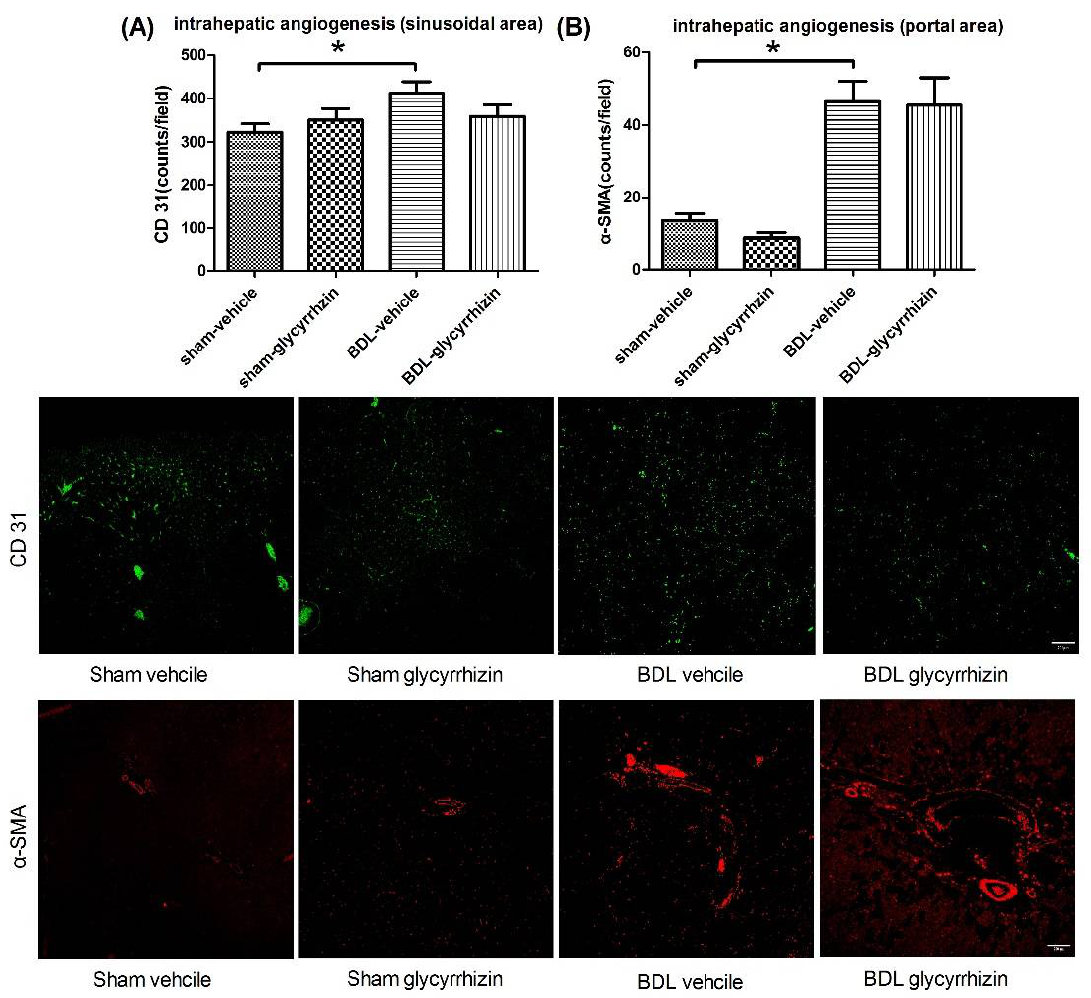
Figure 7. Effects of glycyrrhizin on intrahepatic angiogenesis. ( A ) Intrahepatic angiogenesis over sinusoidal area was evaluated by CD31 staining targeting endothelial cells. ( B ) Intrahepatic angiogenesis over portal area was investigated by α -SMA staining for vascular smooth muscle cells. The results were consistent. Intrahepatic vessels increased significantly in BDL-vehicle group compared with sham-vehicle group. Glycyrrhizin did not significantly influence the vascular numbers in the liver ( n = 6, 6, 6, 6). Scale bar = 200 μm. * p < 0.05